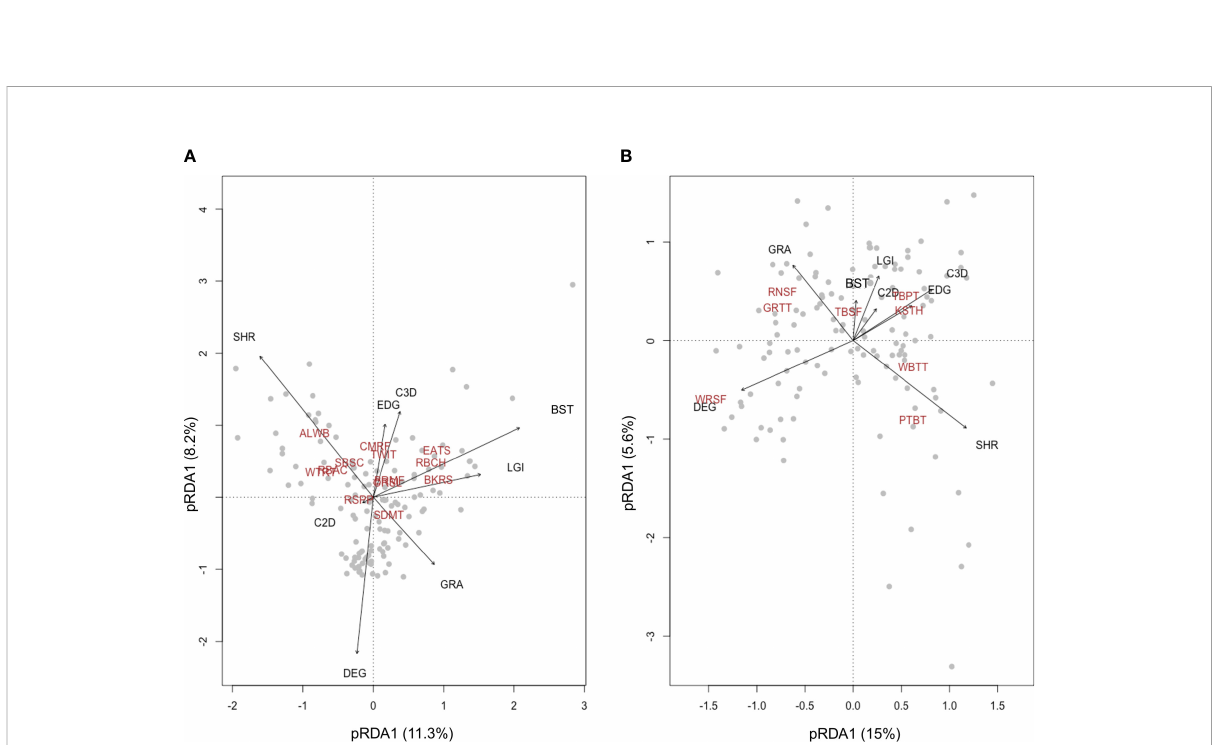
FIGURE 3 Biplots of the fi rst two redundancy analysis (RDA) axes for bird assemblages containing 12 common species (A) and eight endemic species (B) . The proportion of total variation explained by the fi rst two axes is provided. The biplots show species replacement in the pastoral landscape is driven by the spatial change of different habitat variables. Abbreviations for bird species and habitat variables are provided in Tables 1 and 2.